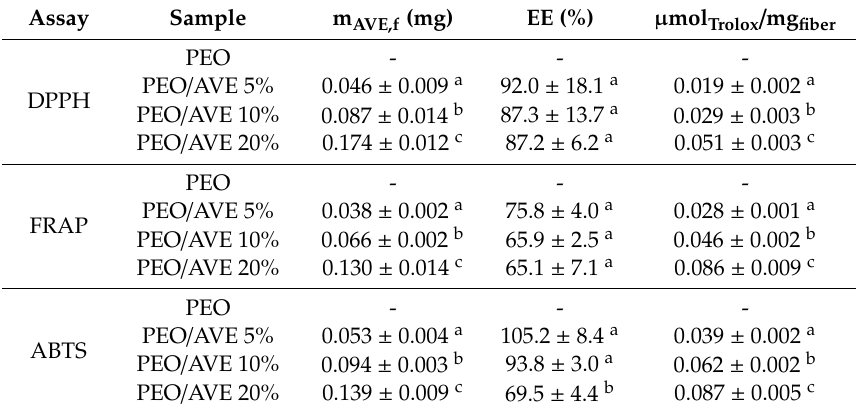
Table 2. Antioxidant activity of PEO / AVE nanofibers (t = 300 min). Mean ± SD (n = 3). Assay Sample m AVE,f